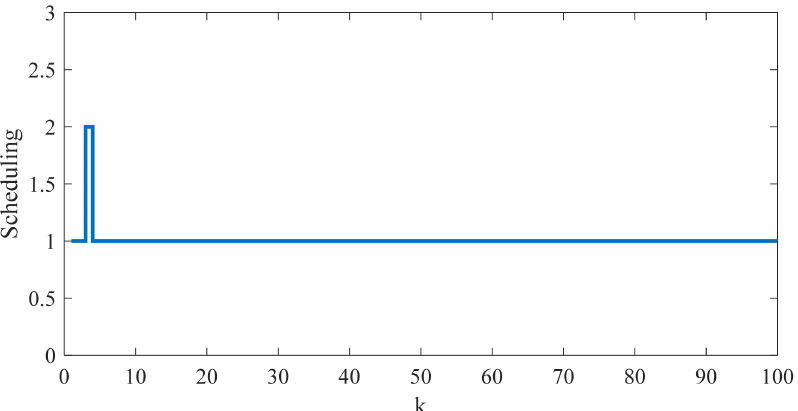
Figure 8. Scheduling of the co-design of the control and GMRS for the NCS with zero-order